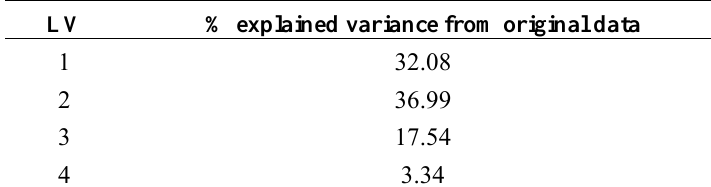
Table 4. Variance explained PLS